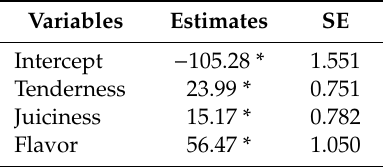
Table 2. Impacts of attributes on overall satisfaction using a random utility